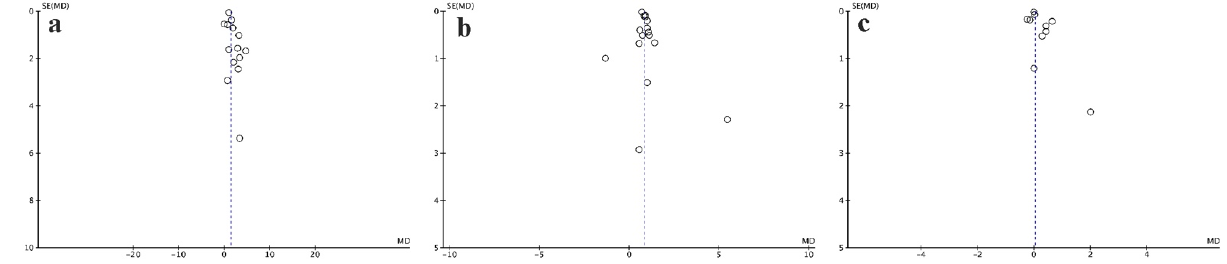
Figure 3. ( a ) Funnel plot for FGP; ( b ) RL; and ( c ) SL. The dotted lines represent the overall effects; hollow circles represent the